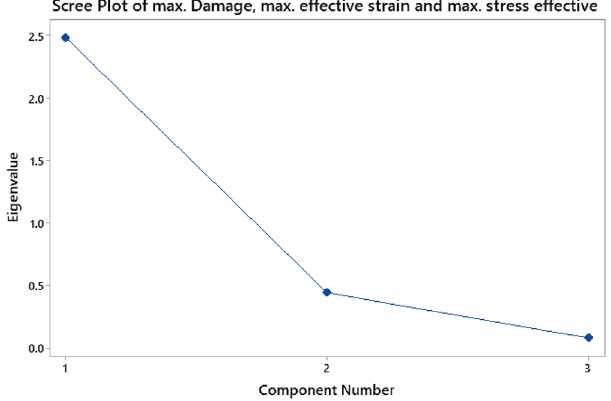
Fig. 4 The scree plot of dam- age, effective strain and stress